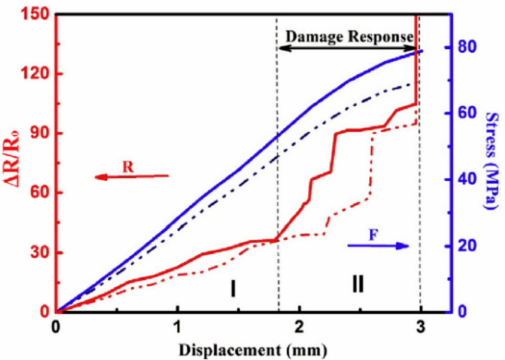
Figure 17. Electromechanical behaviors of GN / epoxy composites. Solid and dotted lines denote two samples. Reproduced with permission from [127]. Copyright 2016, Elsevier.